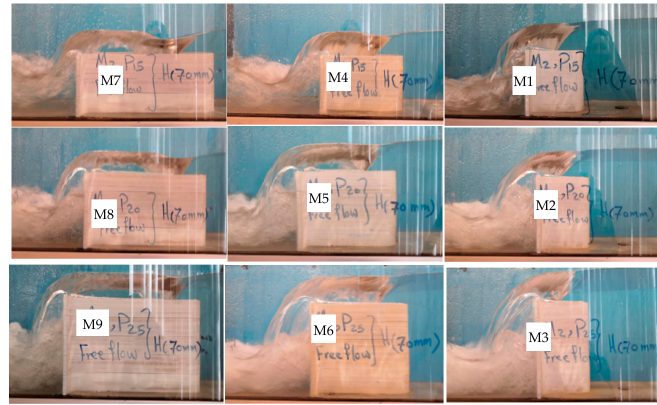
Figure 4. Photographs of the models, h = 70 mm.